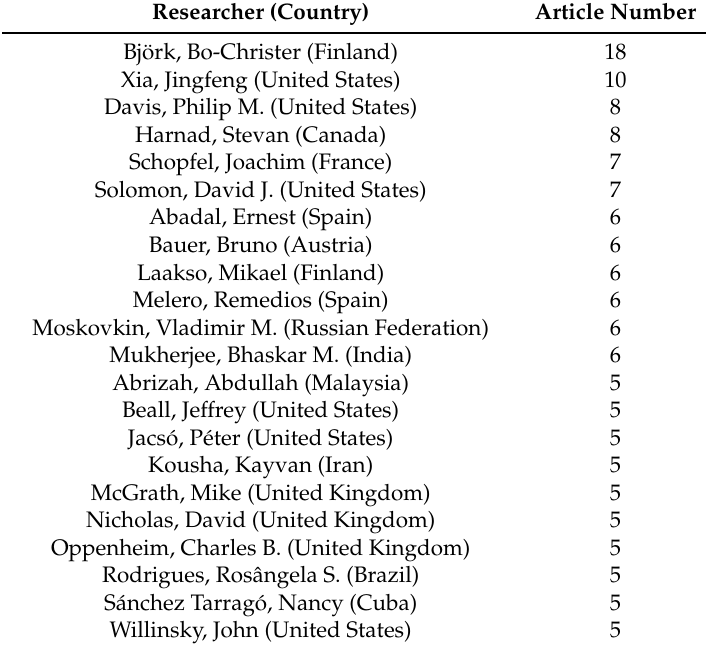
Table 2. Most productive researchers on the theme open